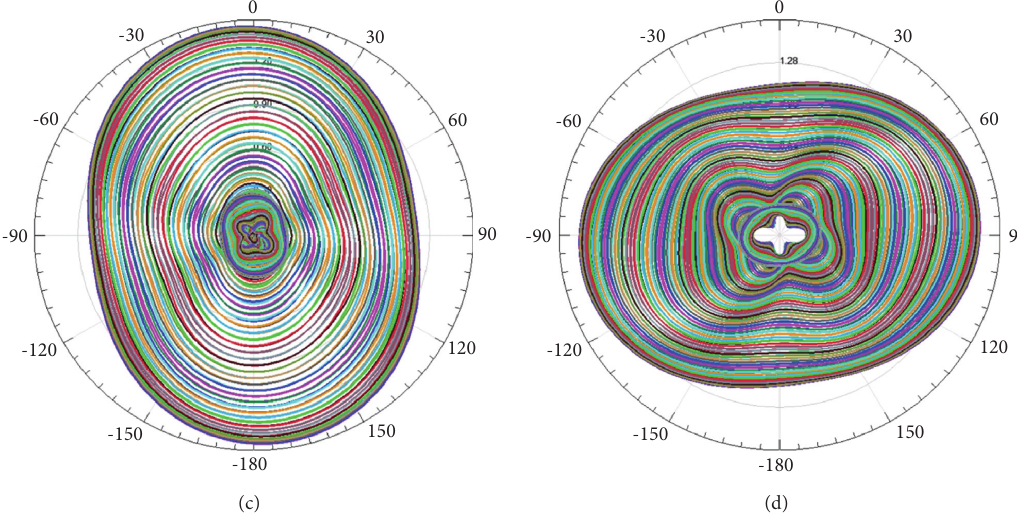
Figure 13: Simulated magnitude of electric field radiation patterns for the optimized antenna.